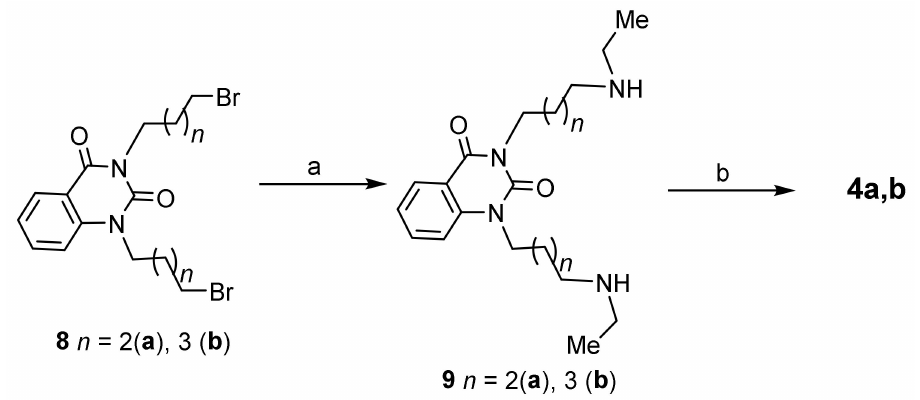
Scheme 2. Synthesis of title compounds with quinazoline-2,4-dione moieties. Reagents and